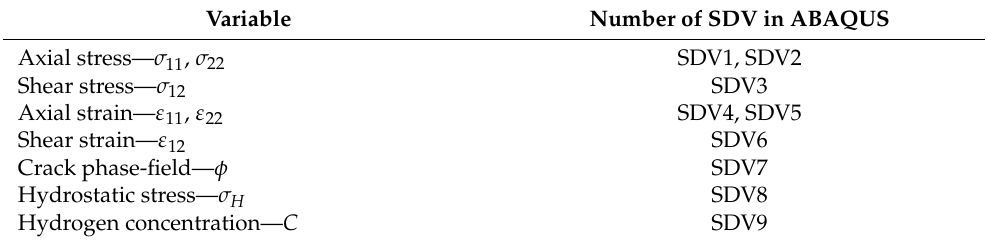
Table 1. List of solution-dependent state variables in two-dimensional.